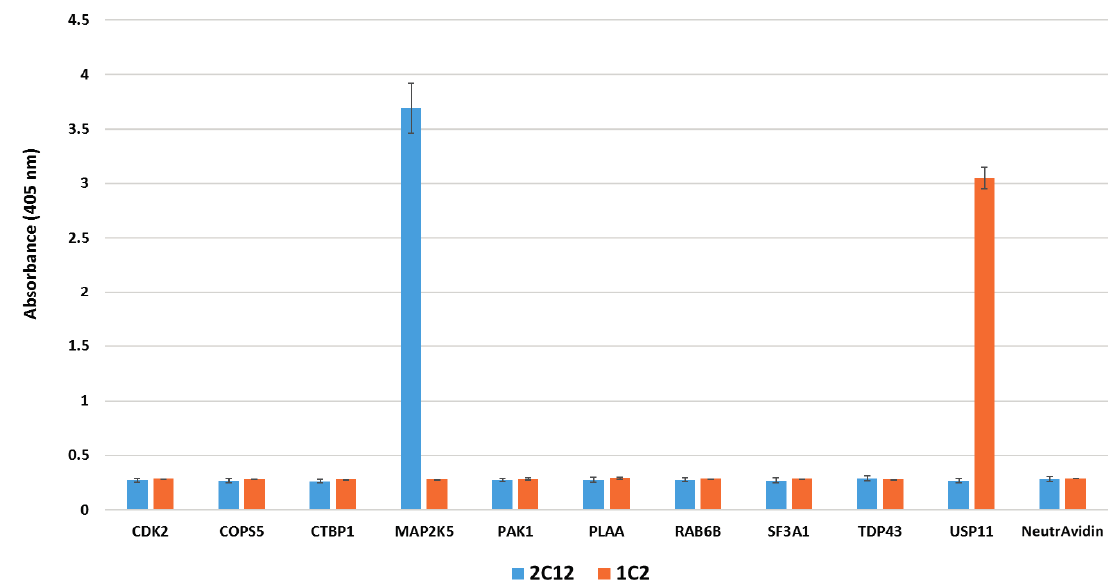
Figure 4. Affinity-matured monobodies bound specifically to their targets in enzyme-linked immunosorbent assay (ELISA). Virions displaying affinity-matured monobodies binding to mitogen-activated protein kinase kinase 5 (2C12) and ubiquitin carboxyl-terminal hydrolase 11 (1C2) were tested in phage ELISA for specificity against a panel of nine other biotinylated targets. NeutrAvidin was used to immobilize the targets to the well. Phage particles bound to the target were detected via anti-M13-horseradish peroxidase (HRP) antibody. Both clones specifically recognized their cognate